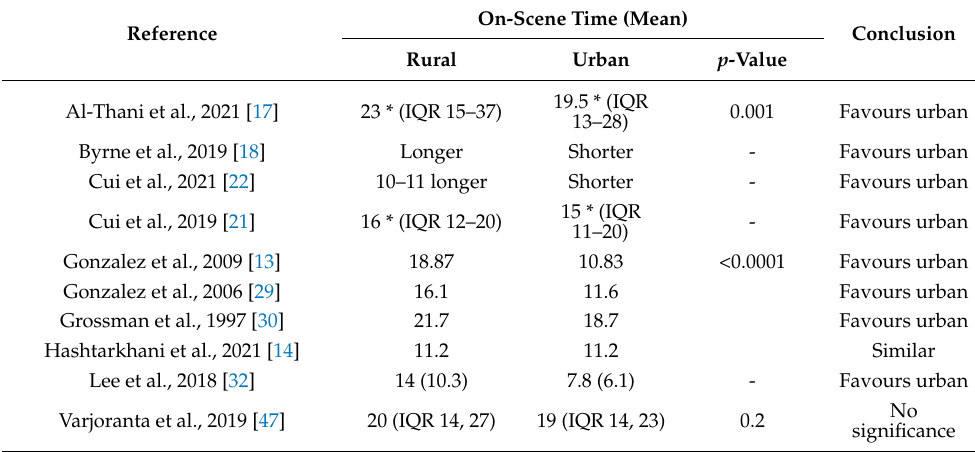
Table 4. Differences between rural and urban areas regarding on-scene time.